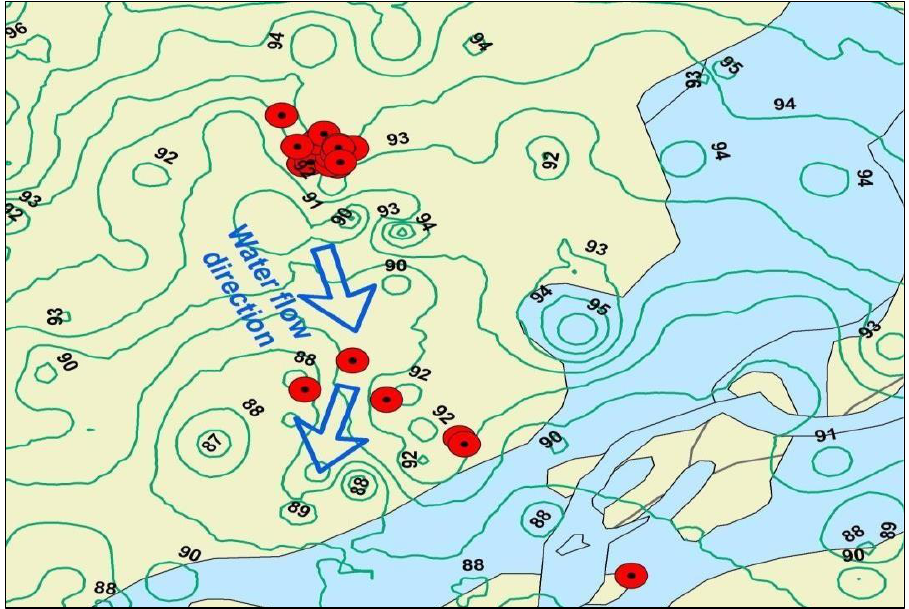
Figure 7. The DEM shows the direction of water in the sampling area and the adjoining Indus River .